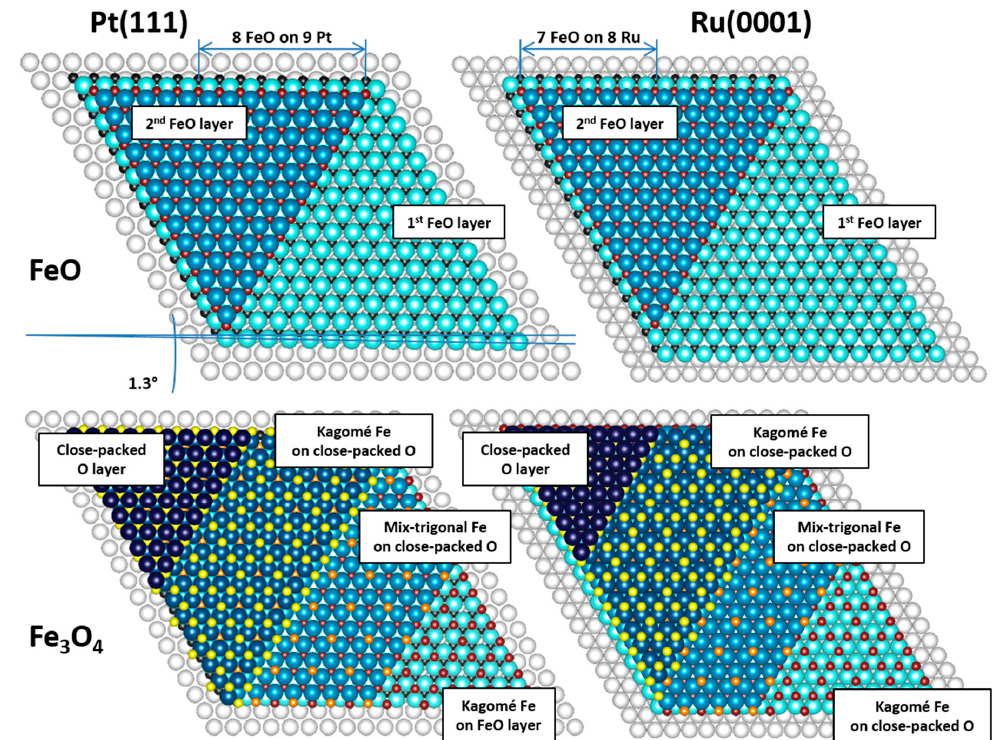
Figure 5. Schematic models of FeO(111) and Fe 3 O 4 (111) structures on Pt(111) and Ru(0001). The atoms in different iron and oxygen sublattices are partially removed to better visualize their different arrangement within different sublayers. The models were made using VESTA 3.4.3 computer software [25].